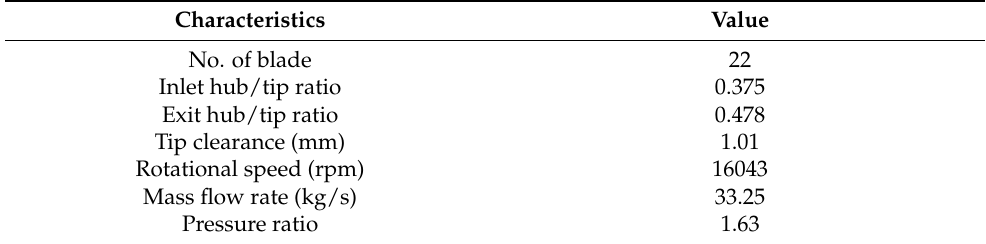
Table 3. NASA Rotor 67 specification.